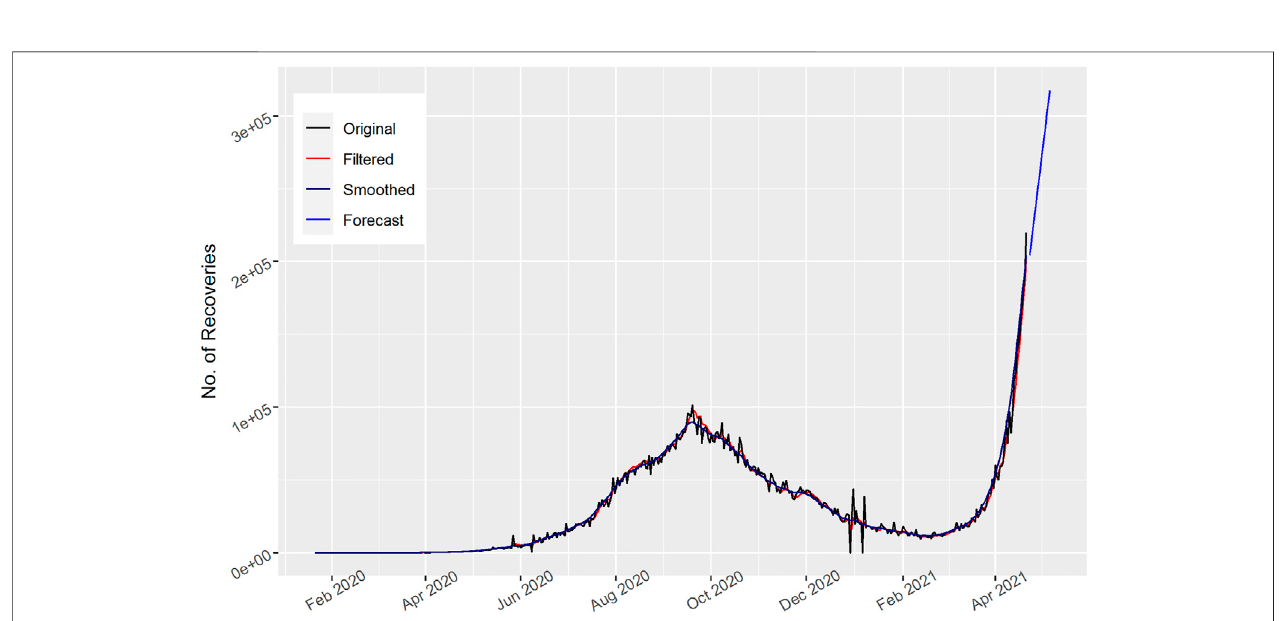
FIGURE 10 | Number of daily recovered cases of